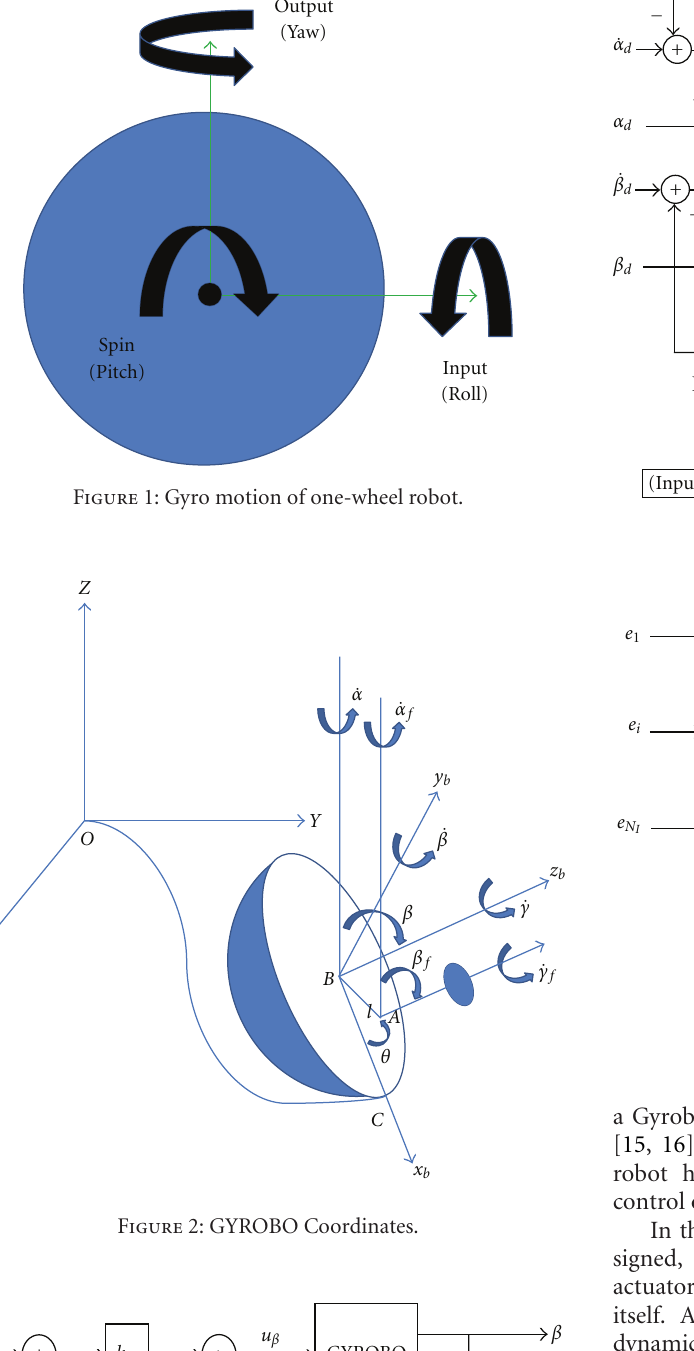
Figure 2: GYROBO Coordinates.